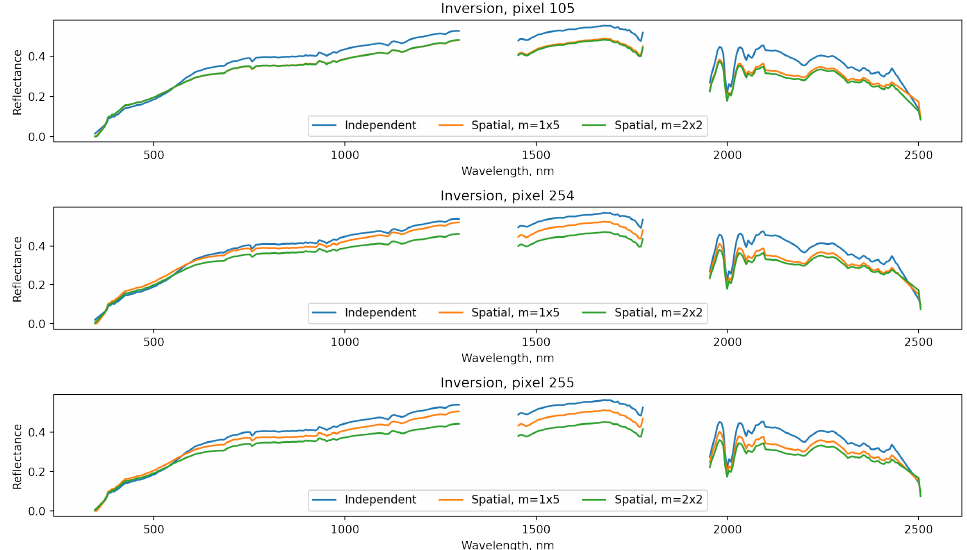
Figure 8. The surface reflectance profiles are nearly identical for the Cuprite data, with scaling changes due to the estimation of atmospheric parameters. This suggests that independent inversions may be overestimating reflectance. Pixels 105, 254, and 255 are adjacent and the reflectance can be interpreted as a percent, so at a particular wavelength a reflectance of 0.4 means 40% of the incoming radiant energy is reflected.